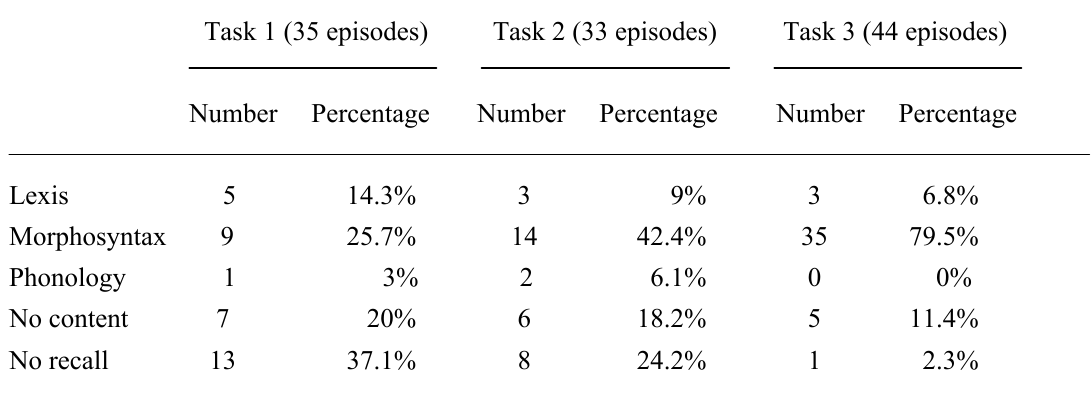
Content of stimulated-recall comments, by